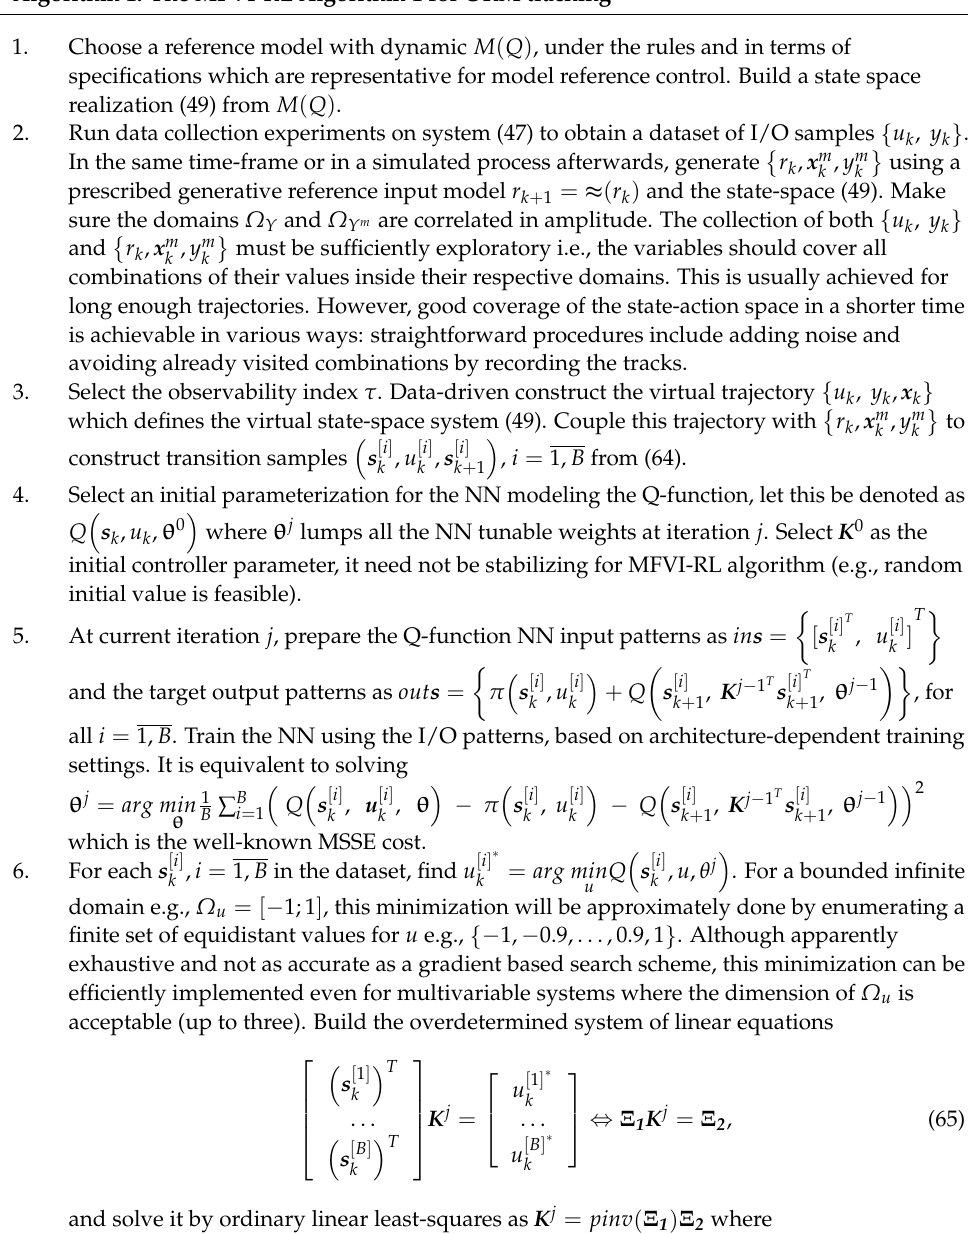
Algorithm 1. The MFVI-RL Algorithm 1 for ORM